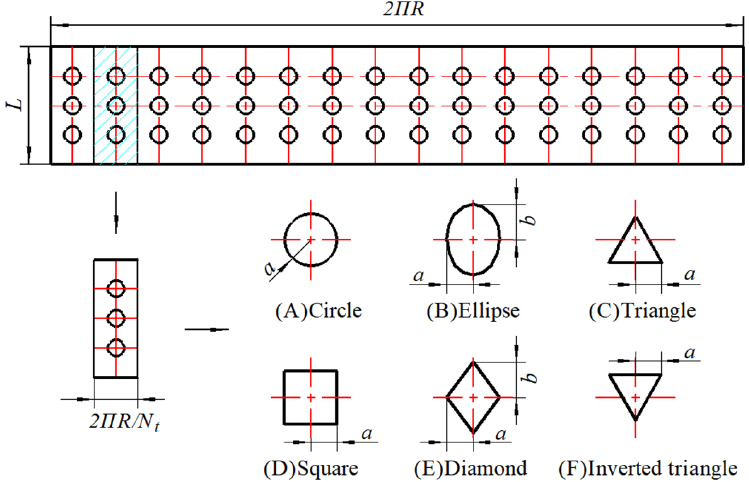
Figure 3. Distribution of the micro-textures.